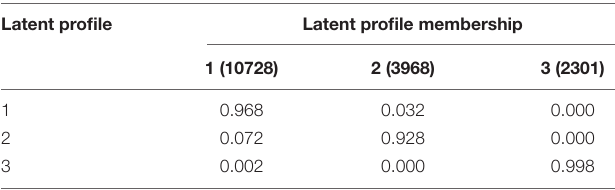
The columns refer to latent profile, and the rows refer to most likely profile membership. Profile 1 = minimal depression; Profile 2 = mild depression; Profile 3 = moderate-severe